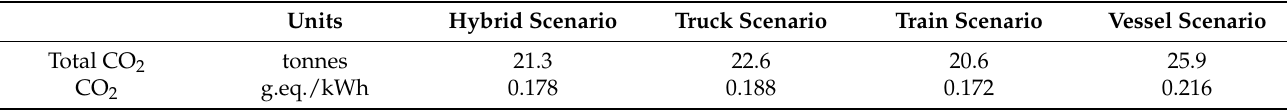
Table 7. Results for different transportation